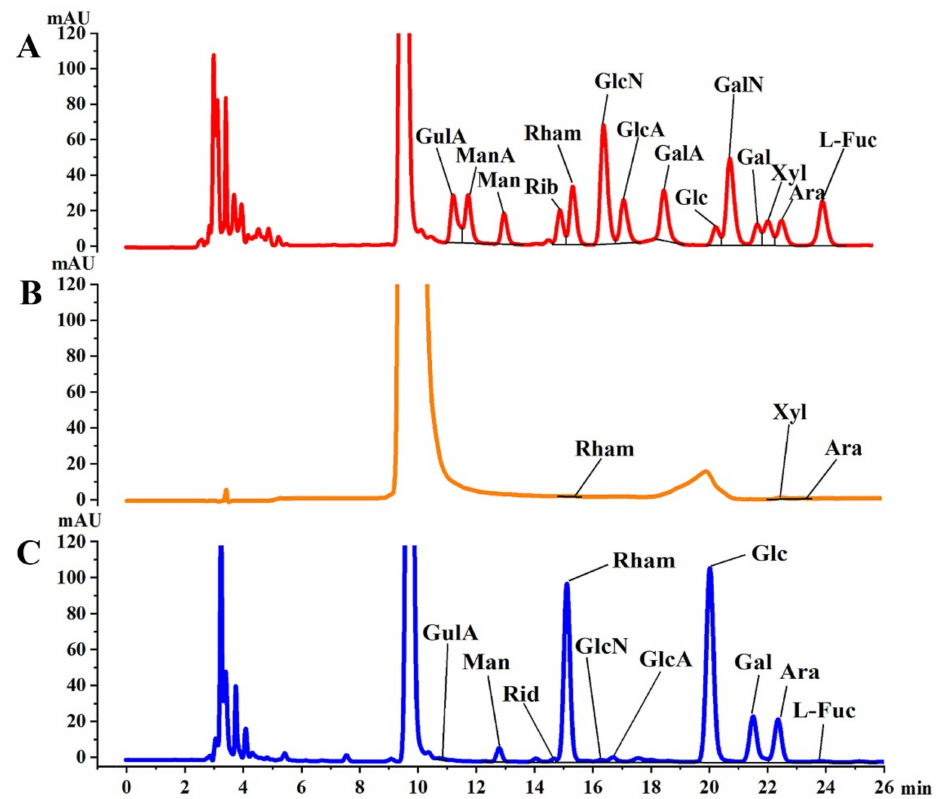
Figure 2. Total ionic flow diagram of standard monosaccharide chromatogram ( A ), PFSI-1 ( B ), and PFSI-2 ( C ) of